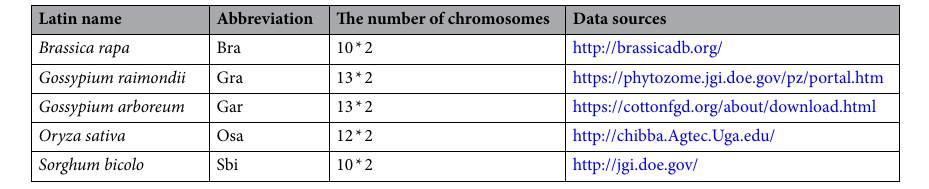
Table 1. Genomic data